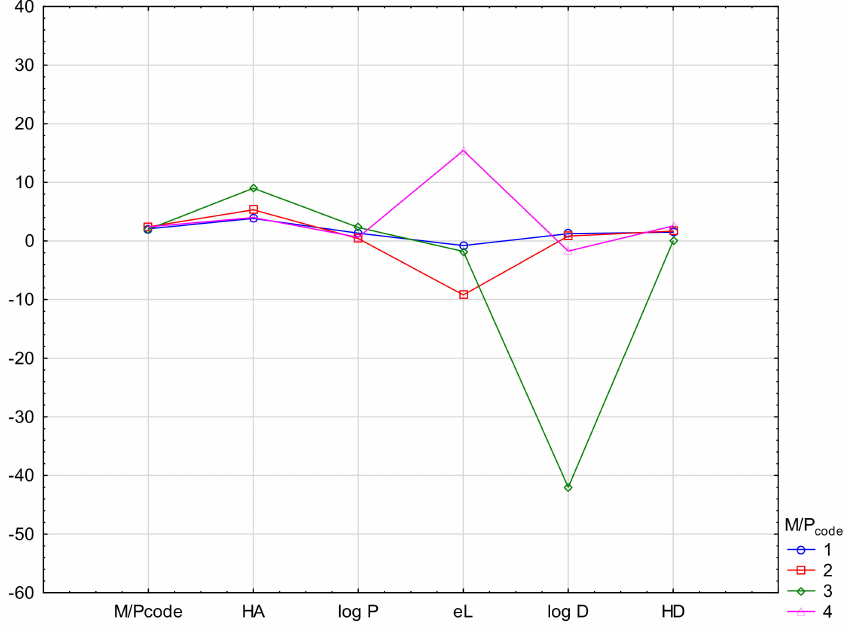
Figure 5. Mean descriptor values in M/P code cluster analysis (k-means method) using physicochemi- cal